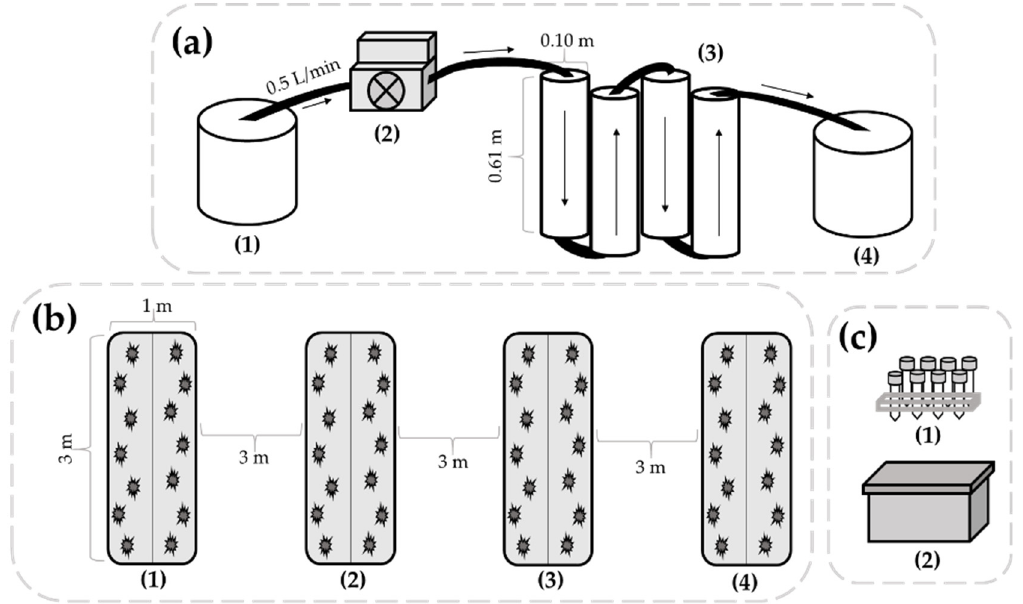
Figure 1. Schematics of the water filtration unit ( a ), agricultural plots ( b ), and water sample storage area ( c ) used in this study. Filtration ( a ) was performed by collecting irrigation water in a sterile container (1), connecting the peristaltic me- tering pump (2), and pumping the water through the filtration unit (3) into the collection container (4). The direction of water movement is indicated by the arrows. The agricultural plots ( b ) were each 3 × 1 m in size, with 3 m buffer areas between plots. Plots (1) and (2) were amended with composted and raw poultry litter, respectively, and irrigated with filtered water throughout the trial. Plots (3) and (4) were amended with composted and raw poultry litter, respectively, and irrigated with unfiltered water throughout the trial. Irrigation water ( c ) for the evaluation of bacterial persistence was stored in sterile centrifugal tubes (1), inside a secondary container (2), located adjacent to the agricultural plots. 2.2. Construction of Filtration Apparatus The filtration unit was constructed using polyvinyl chloride (PVC) pipes and fittings connected by PEX cross-linked polyethylene tubing (SharkBite, Cullman, AL, USA). As shown in Figure 1a, unfiltered water was stored in a sterile container (1) and water was pumped through the filtration unit at a rate of 0.5 L/min using a 25.3 GPH standard peri- staltic metering pump (2) (Cole Parmer, A3 Series). Four filtration columns were aligned vertically to allow water to flow through sequentially (3). Each column (4 in diameter × 2 ft length PVC) was filled with either 100% sand (first and fourth columns), or a homoge- nous blend (50:50) of sand and zero-valent iron (second and third columns). The first col- umn with sand was designed to remove large particles within the water and increase po- tential contact between the bacterial contaminants in the second and third ZVI and sand columns. The final column of sand was implemented to prevent any potentially dislodged iron particles from leaving the filtration unit. Sand (Northern Filter Media, Muscatine, IA, USA) and ZVI (Peerless Metals, Detroit, MI, USA) particles were prepared as previously described [22], and the filtration unit had a total pore volume of 10 L. Water was collected in an additional sterile container (4) prior to irrigation and sample collection. 2.3. Collection and Management of Water Water was collected from a pond in the Mid-Atlantic region of the United States. This site, MA11, was previously characterized by the CONSERVE team and is currently used as a non-traditional source of agricultural irrigation water [3,21,23]. The water was col- lected prior to each irrigation event (days 0, 10, 20, 30, 40, and 50) and transported to the laboratory. Water was diluted 10-fold in sterilized Milli-Q Ultrapure water. Additionally, 1 L volumes of water from MA11 were stored at refrigeration temperature to be used to flush the filtration systems every 48 h, using 15 L volumes, between irrigation events.